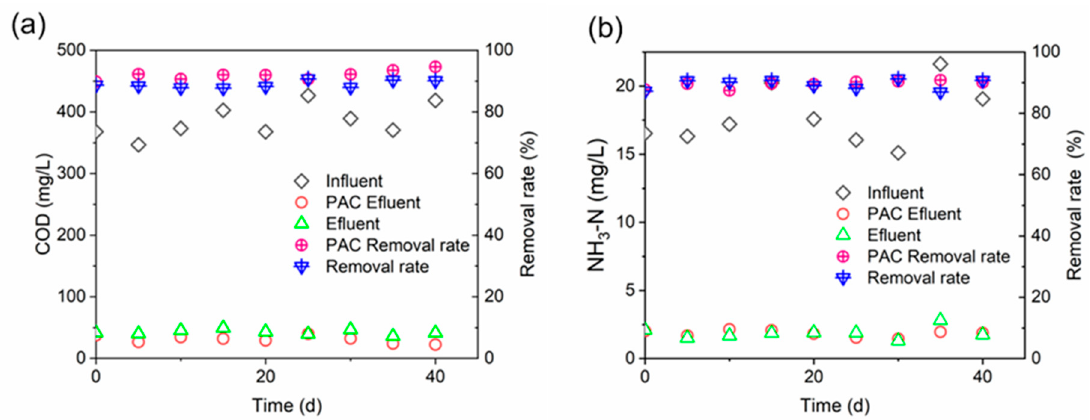
Figure 2. Performance of DMBR in synthetic wastewater treatment ( a ) COD removal; ( b ) NH 3 –N removal in the reactor.